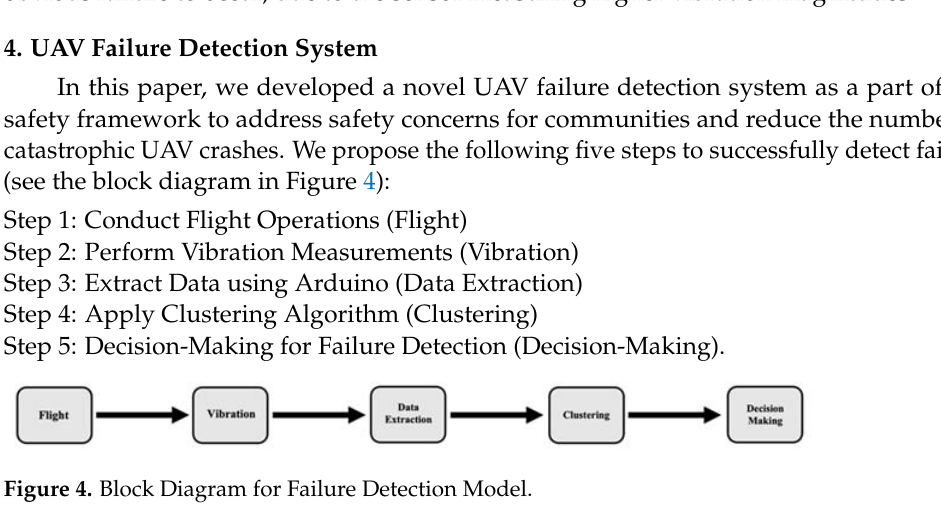
Figure 3. Cases for Propeller Faults with ( a ) Healthy, ( b ) One Set of Faulty Propellers (1SFP), and ( c ) Two Sets of Faulty Propellers (2SFP).